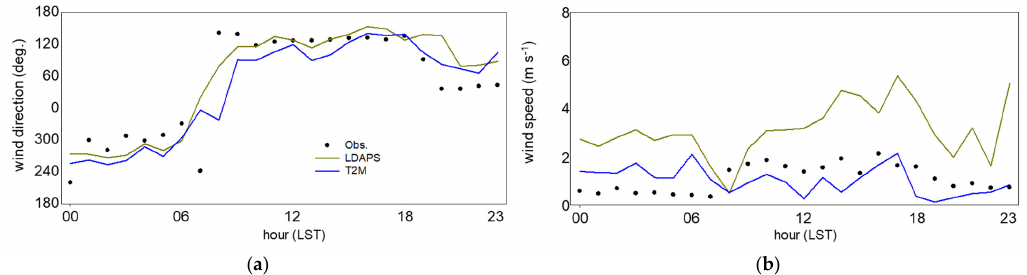
Figure 3. Time series of the measured and simulated ( a ) wind directions and ( b ) wind speeds at PKNU ‐ SONIC (red dot in Figure 1a). Table 3. The statistical values of the wind speeds (m s − 1 ) simulated at PKNU ‐ SONIC (red dot in Figure 1a).